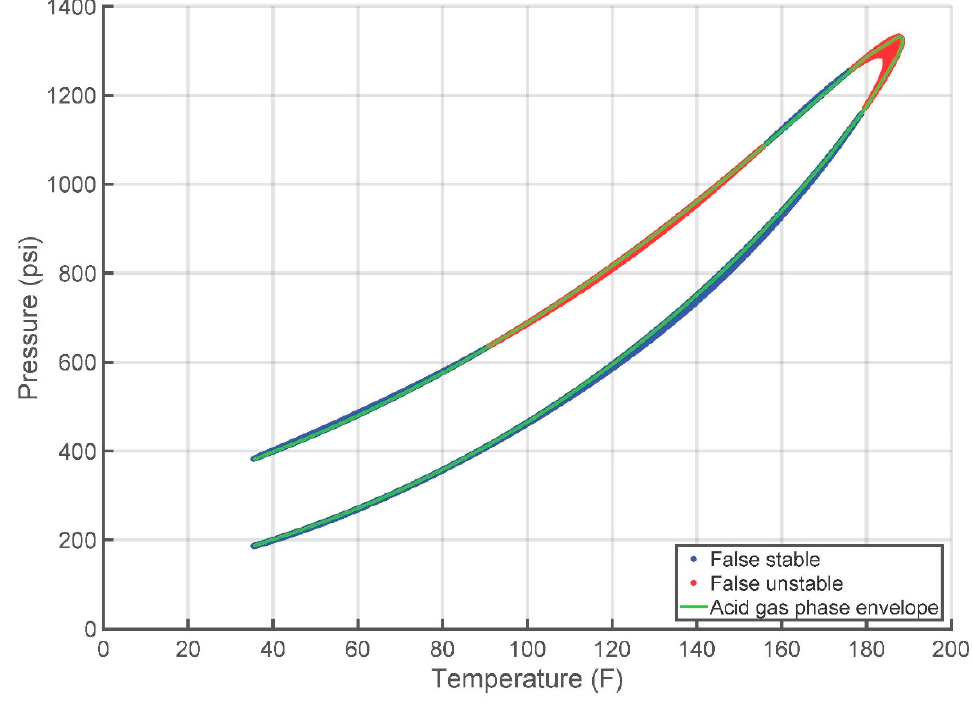
Figure 7. Visualization of the SVM model results on testing datapoints.